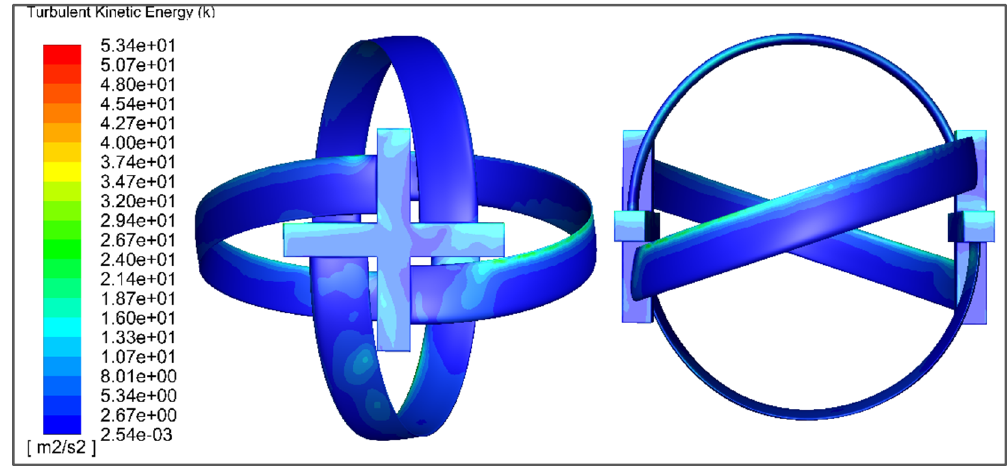
Figure 20. The turbulent kinetic energy of the turbine wall showing the variation in turbulent kinetic energy along the turbine wall.